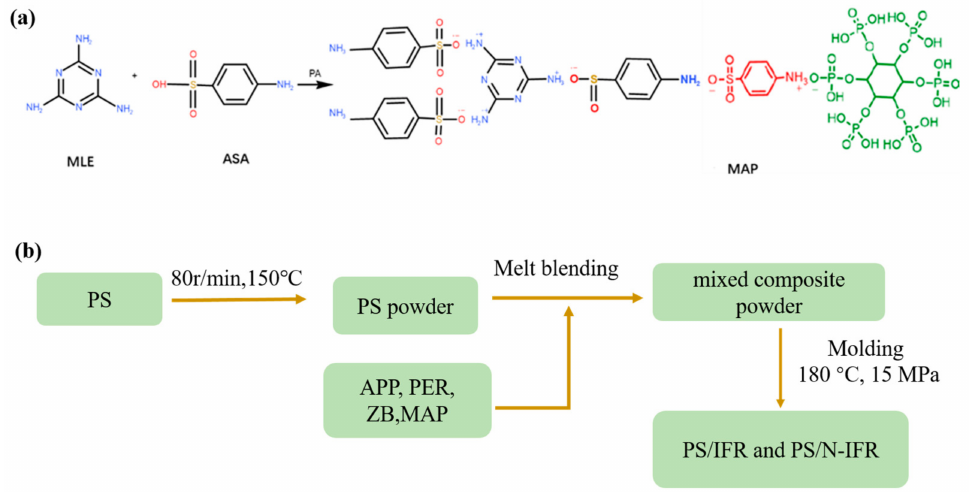
Figure 1. The synthetic route of MAP ( a ) and schematic diagram of expanded flame-retardant polystyrene preparation process ( b